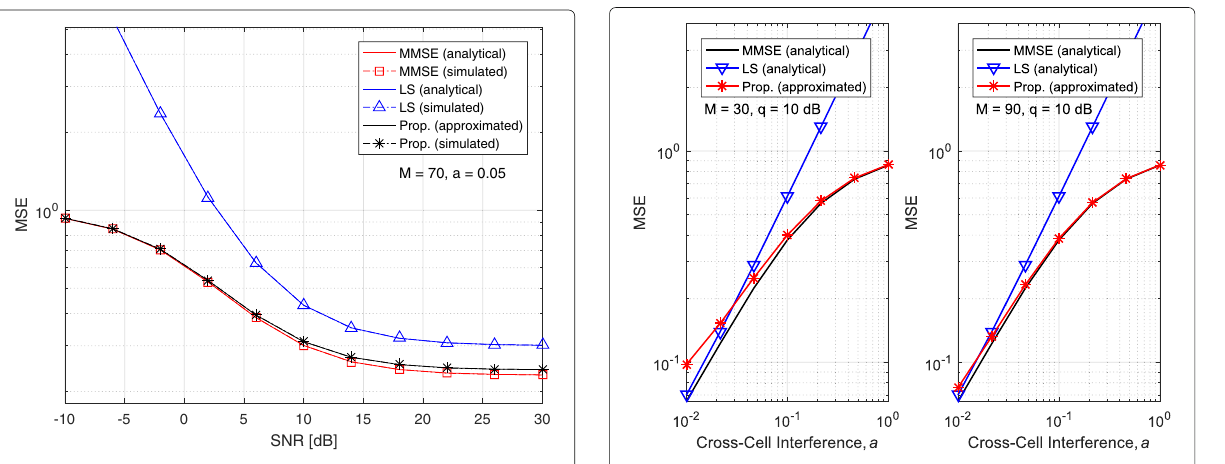
Fig. 5 Channel estimation MSE versus cross-cell interference